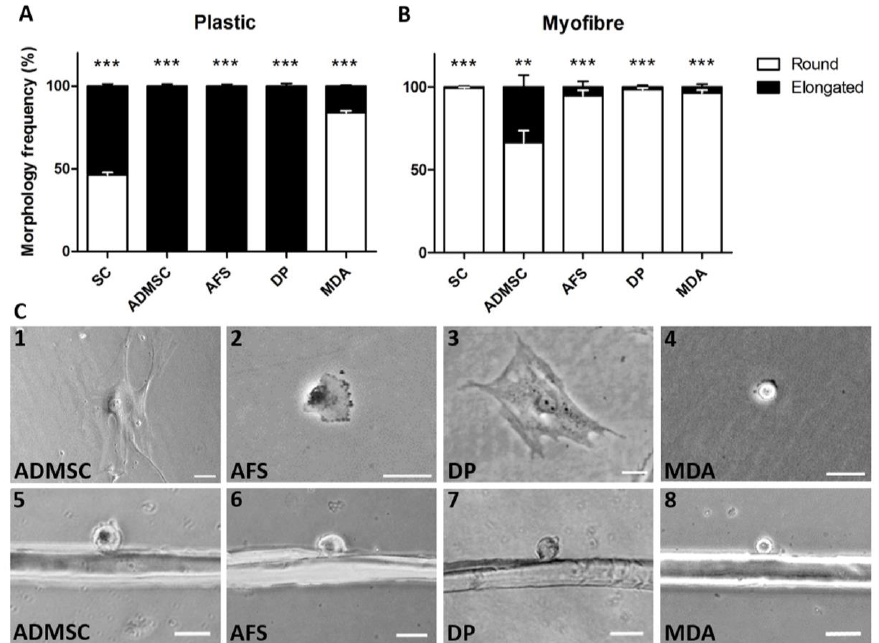
Figure 1. The skeletal myofibre matrix influences non-muscle cellular morphologies. ( A ) Frequencies of morphologies adopted by satellite cells (SC, n = 21 cells examined), adipose-derived mesenchymal stem cells (ADMSC, n = 52), amniotic fluid stem cells (AFS, n = 32), dental pulp stem cells (DP, n = 26) and MDA-MB-231 breast cancer cells (MDA, n = 31), on plastic; ( B ) Cell morphologies displayed by SC ( n = 45 myofibres examined), ADMSC ( n = 34), AFS ( n = 35), DP ( n = 26), and MDA ( n = 43), on myofibres; ( C ) Representative morphologies of non-muscle cells observed on plastic ( 1 – 4 ) and on myofibres ( 5 – 8 ). Scale 50 µ m. Individual Student’s t -tests showed statistical significance between ‘Round’ and ‘Elongated’ morphologies in each cell type, ** p < 0.01, *** p <